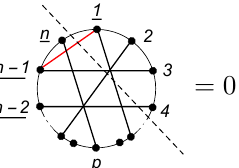
Figure 3 . This particular factorization cut vanishes trivially since there is only one fixed puncture on the upper side of the dashed black line (rule